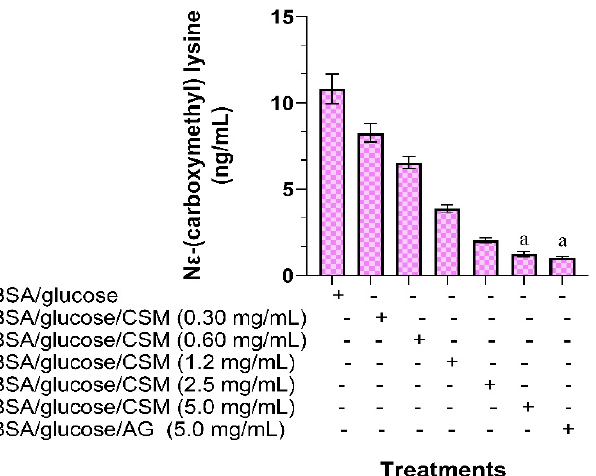
Figure 3. Effect of CSM on the inhibition of N ε -(carboxymethyl) lysine (CML) after four weeks of incubation. Each value represents the mean ± SE. a p ≤ 0.05 when compared to BSA/glucose. The letters indicate significant differences between the different treatments. CSM; methanol extract from the seed of S. purpurea , AG; aminoguanidine.